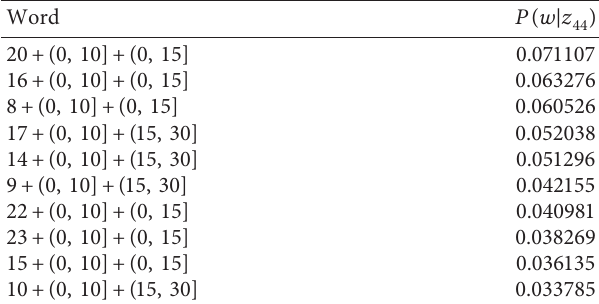
Table 6: Top words for Topic